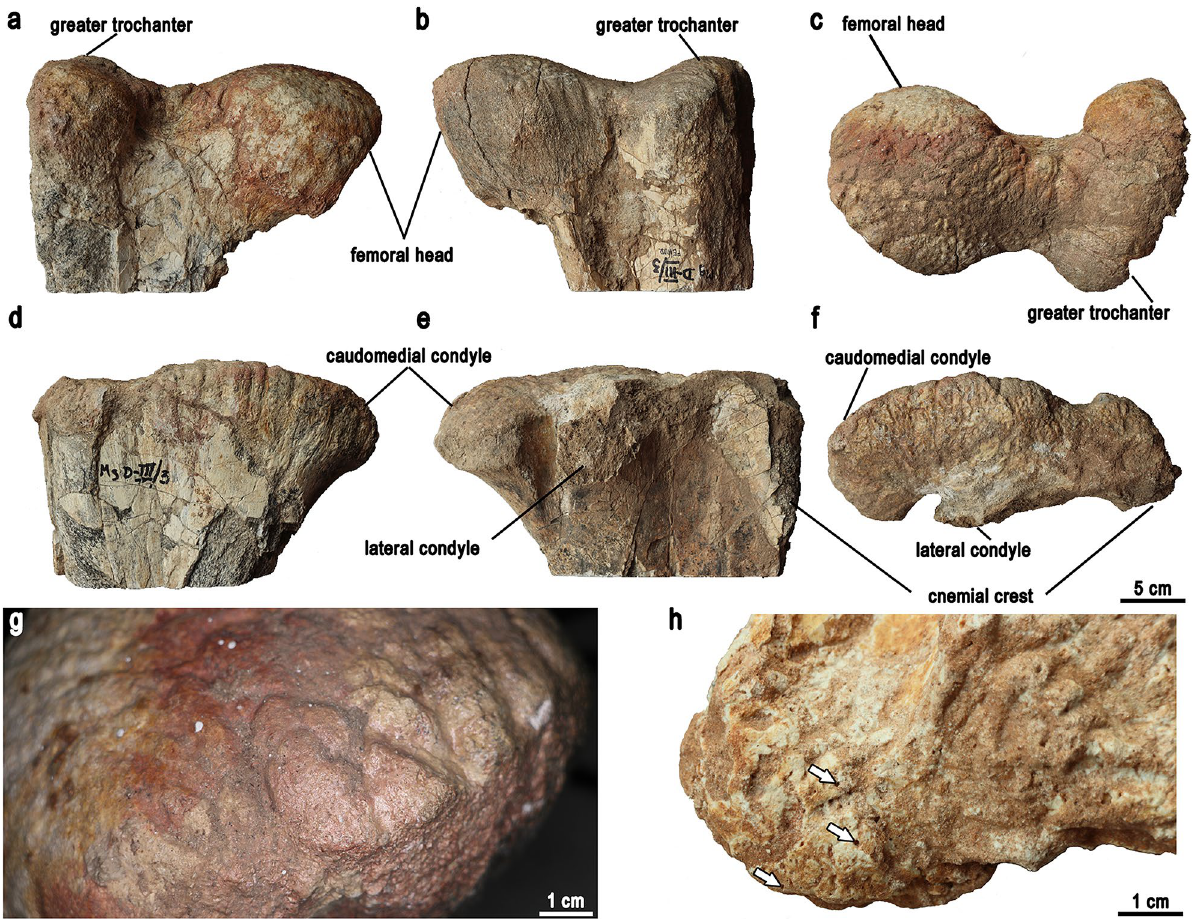
Figure 1. Proximal right femur ( a – c ) and tibia ( d – f ) of Gobihadros mongoliensis . Proximal right femur in cranial ( a ), caudal ( b ), and dorsal ( c ) view. Proximal right tibia in medial ( d ), lateral ( e ), and dorsal ( f ) view. Surface of the proximal femur without transcortical channels ( g ). Left distal femur of Protoceratops andrewsi (ZPAL MgD-II/11) showing open transcortical channels marked by arrows ( h